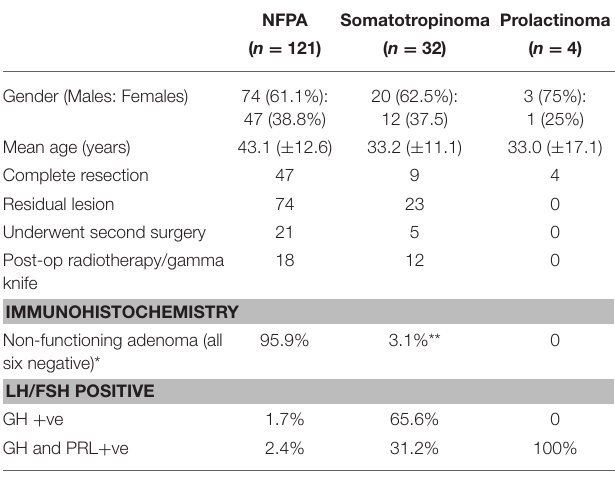
TABLE 2 | Patient characteristics for tissue microarray